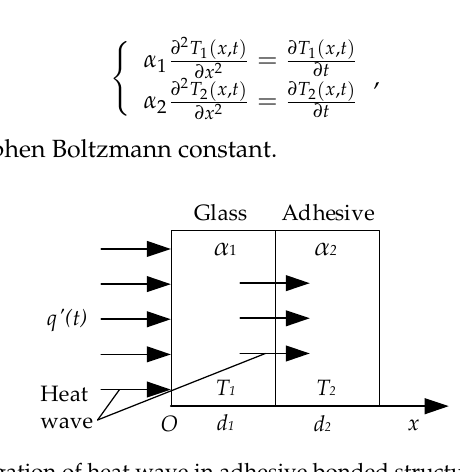
Figure 1. The propagation of heat wave in adhesive bonded structure of glass curtain wall.